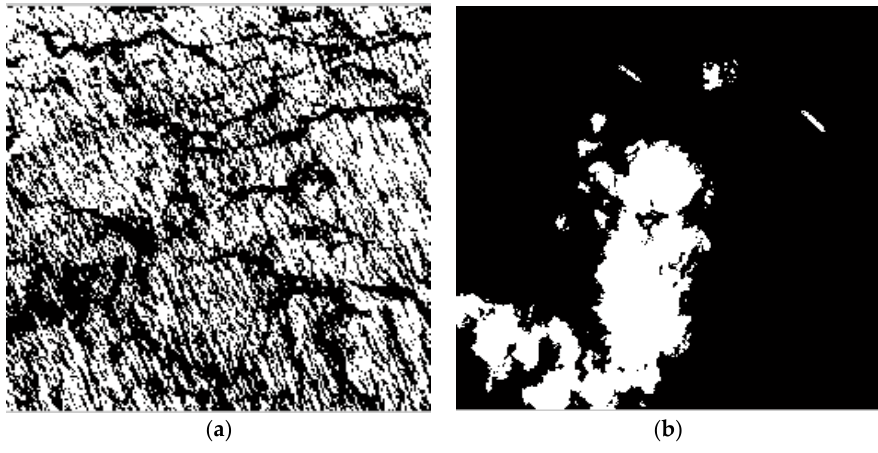
Figure 8. The localization results by Otsu. ( a ) The results of strong waves; ( b ) the results of cloud coverage.